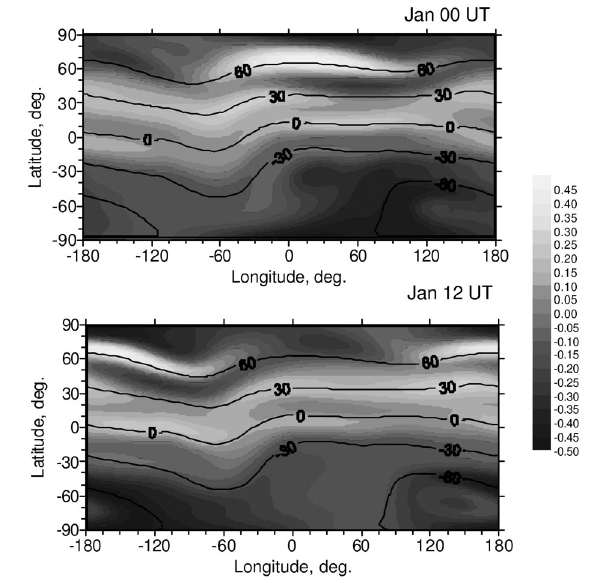
Fig. 3.13. The distribution of the relative deviation Φ of foF 2 from its median value shown for January at 00 UT ( upper panel) and 12 UT ( lower